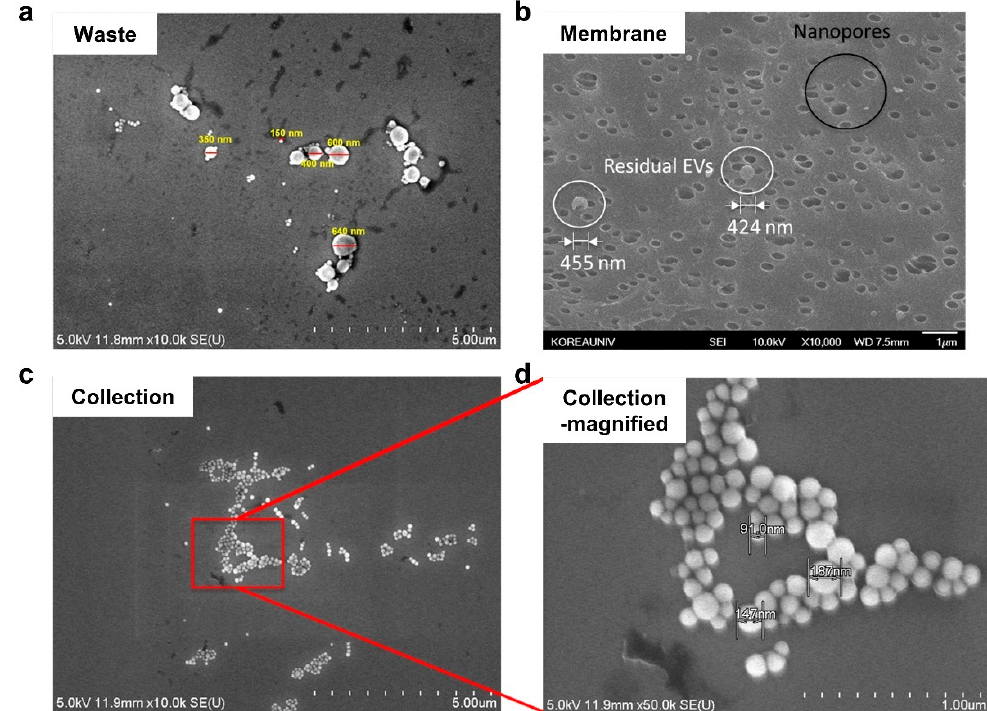
Figure 4. SEM image of separated EVs. ( a ) Sample from inlet shows both exosomes and apoptotic bodies. ( b ) Membrane after elution. Crater-like shapes in the upper black circle are nanopores; spherical features in white circles are apoptotic bodies, which could not pass through the membrane. ( c ) Sample from outlet chamber shows exosomes only. ( d ) Magnified view of the red box in ( c ).